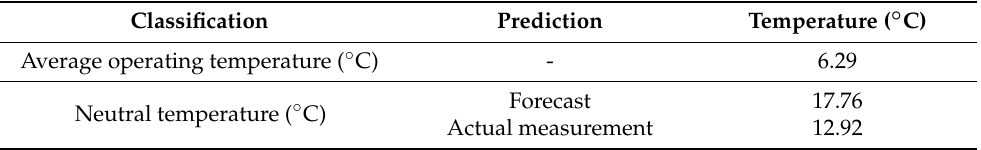
Table 5. Thermal neutral temperature statistics during winter.